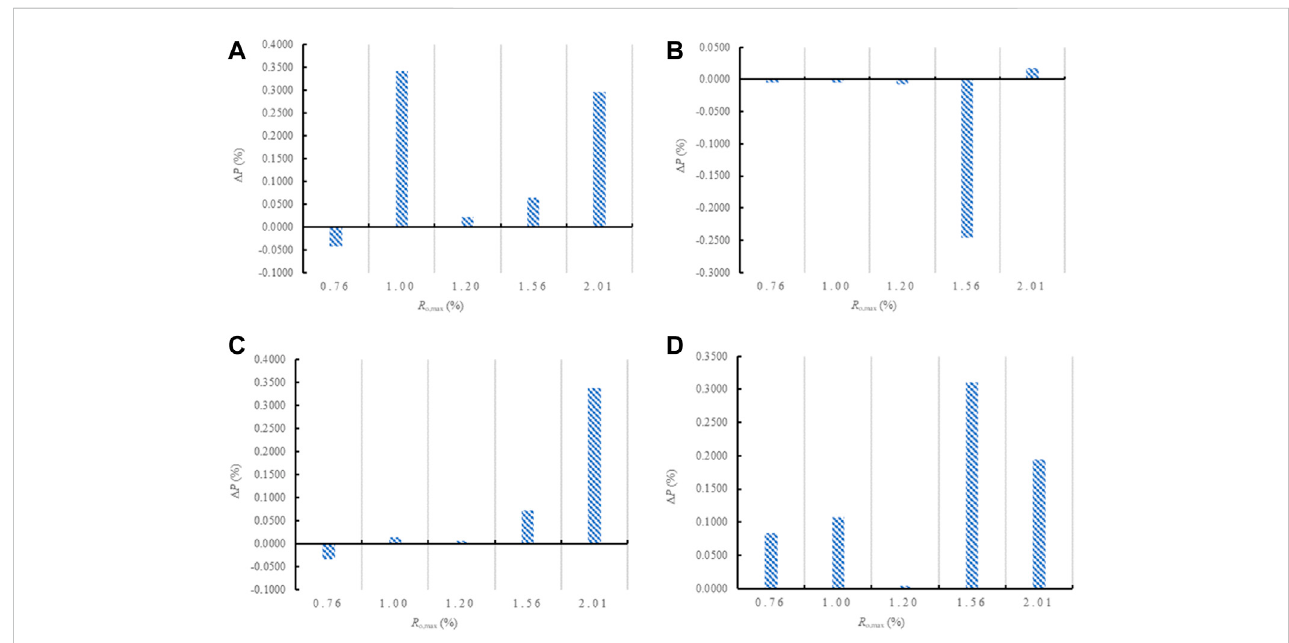
The changes in incremental porosity of coal due to Sc-CO 2 extraction (A) Micropore; (B) Transitional pore; (C) Mesopore; and (D)